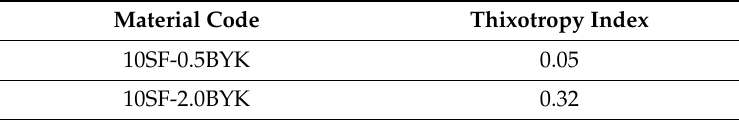
Figure 3. Three interval thixotropy tests for developed material formulations (1: Low shear phase 𝛾(cid:4662) = 1·s − 1 ; 2: High shear phase 𝛾(cid:4662) = 300·s − 1 ; 3: Low shear phase 𝛾(cid:4662) = 1·s − 1 ). Table 4. Thixotropy index of developed magnetic suspensions. Table 4. Thixotropy index of developed magnetic